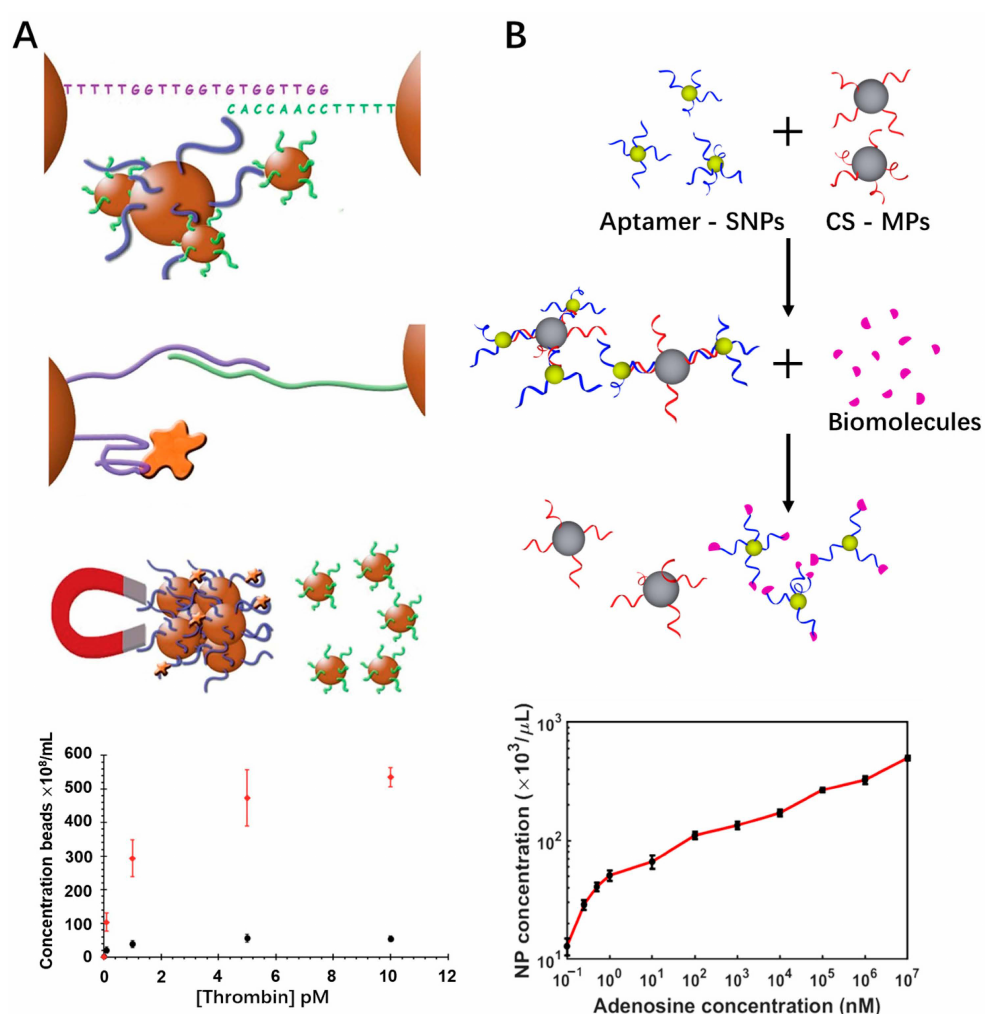
Figure 11. RPS—aptasensors based on NP release. ( A ) Aptamer-based dispersion assay using TRPS for thrombin detection, reproduced with permission from [107] Copyright 2015 Royal Society of Chemistry. ( B ) Mechanism of adenosine detection via aptamer reconfiguration and nanoparticle counting, reproduced with permission from [108]. Copyright 2022 Biosensors and